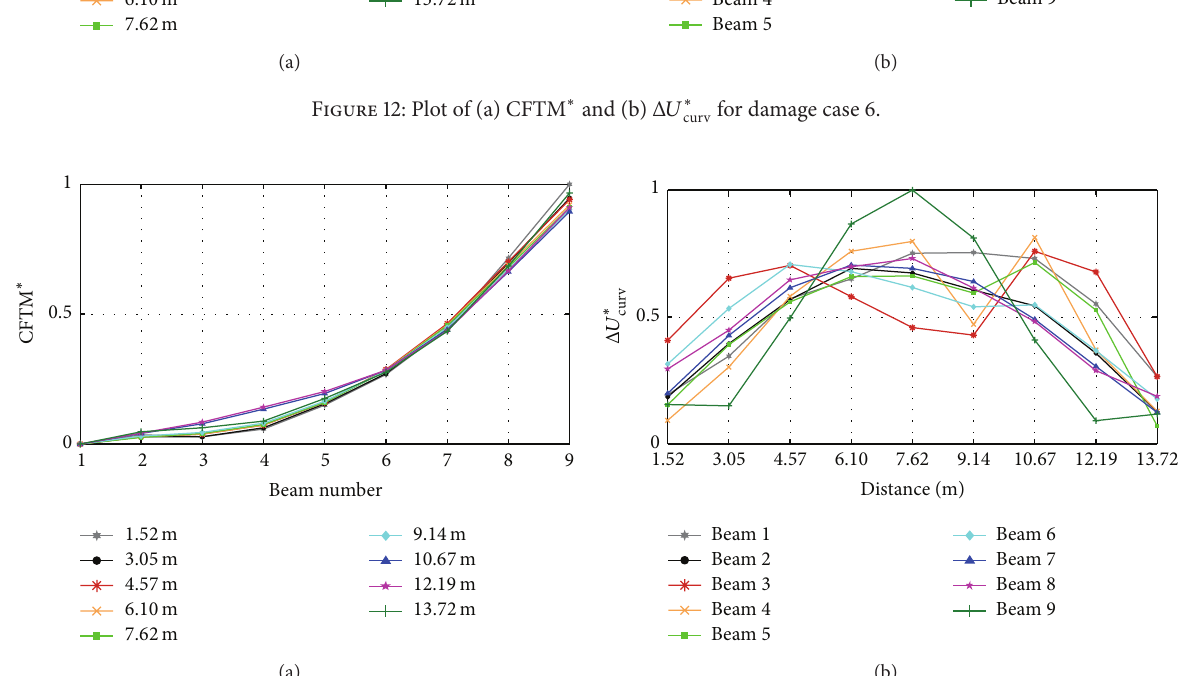
Figure 13: Plot of (a) CFTM ∗ and (b) Δ𝑈 ∗